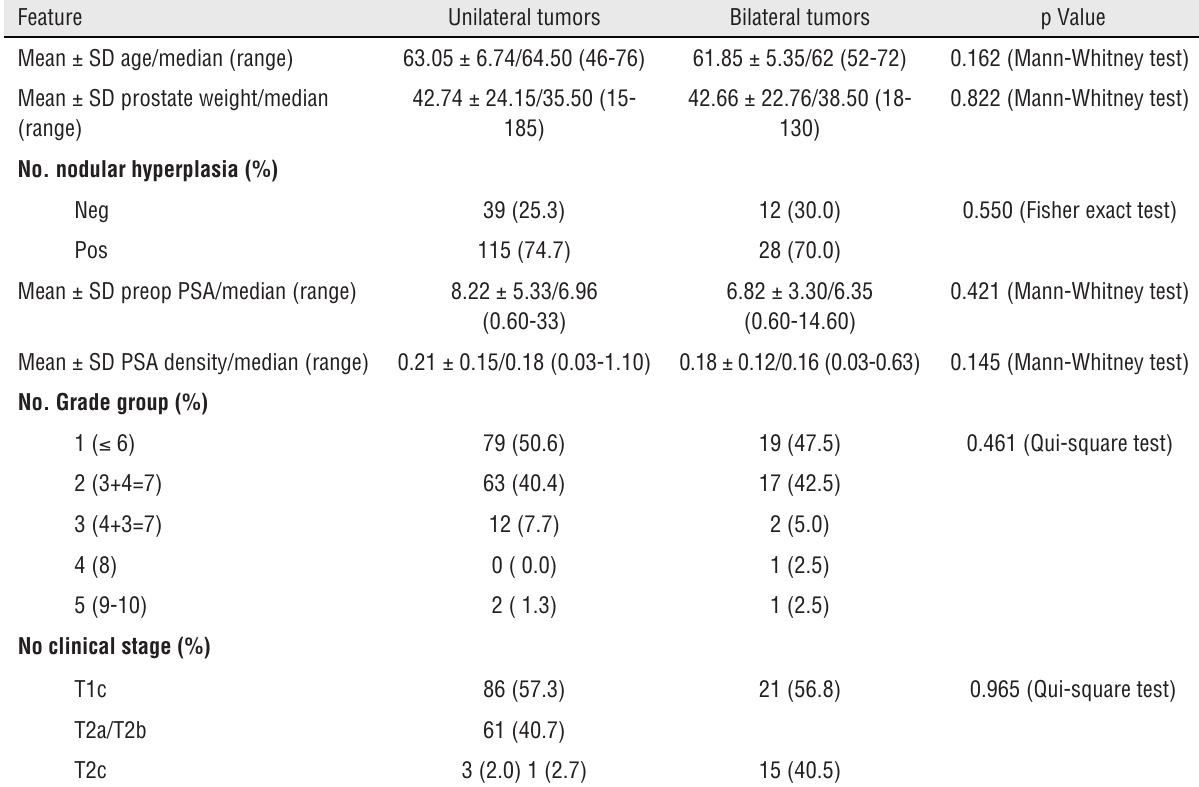
Table 2 - Clinicopathological features of 156/196 (79.6%) unilateral tumors vs 40/196 (20.4%) bilateral tumors evaluated by index tumor extent.